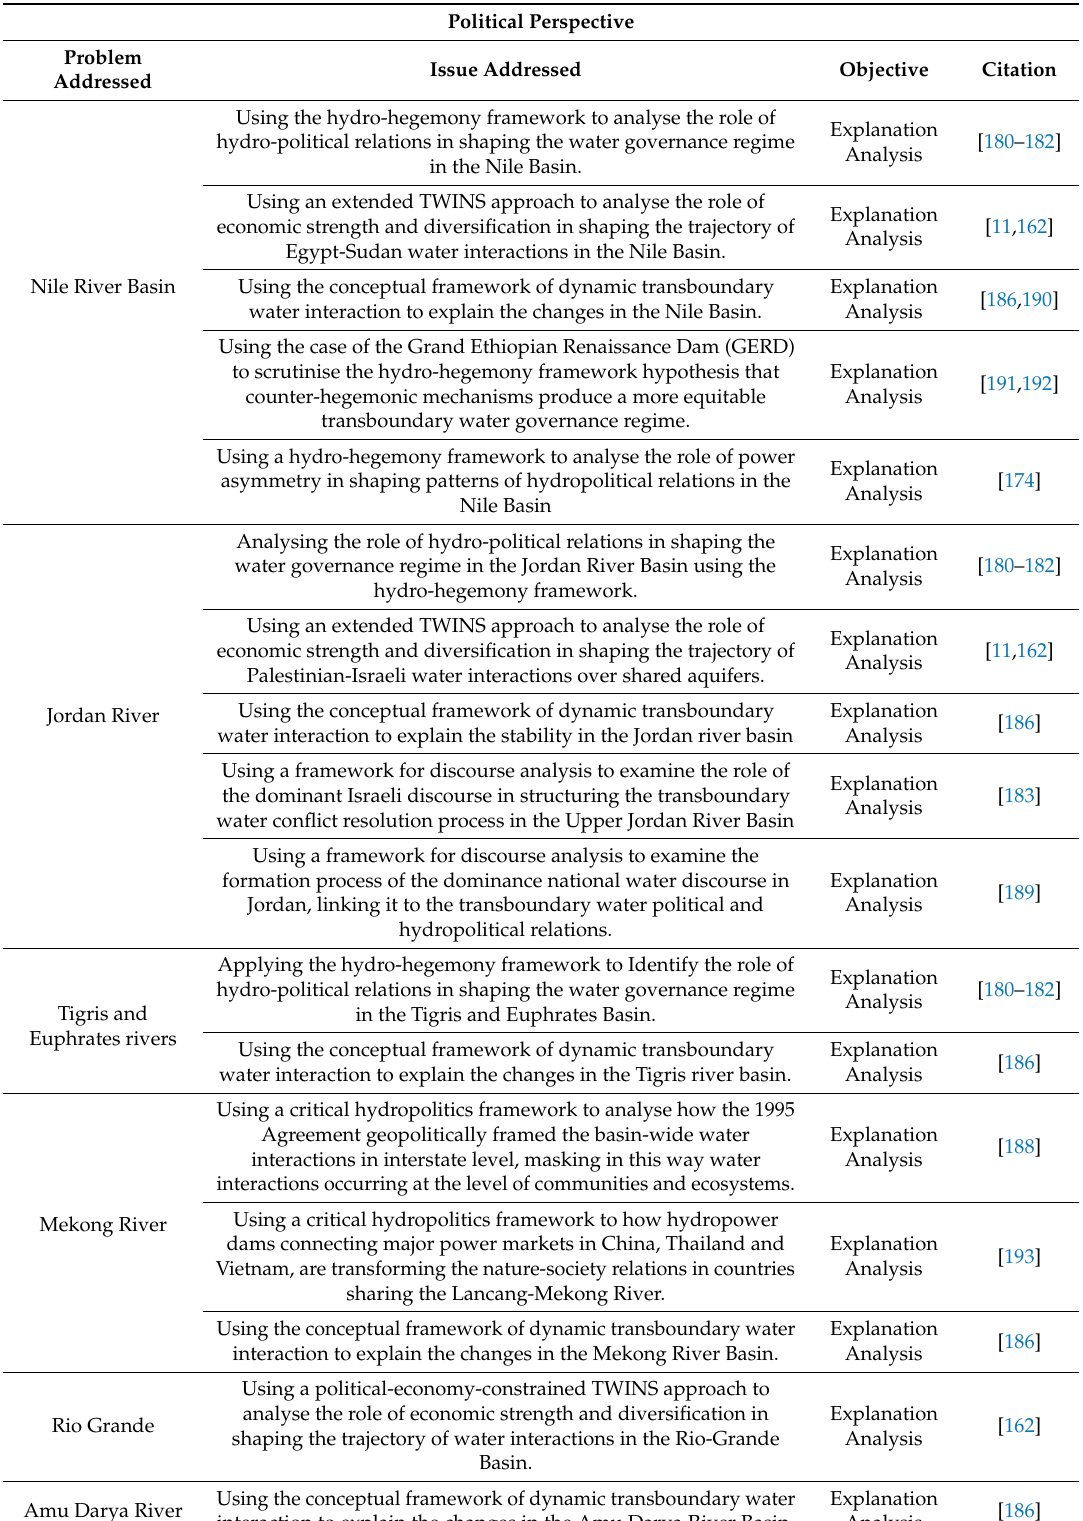
Table 9. Political Mechanisms—Theory and